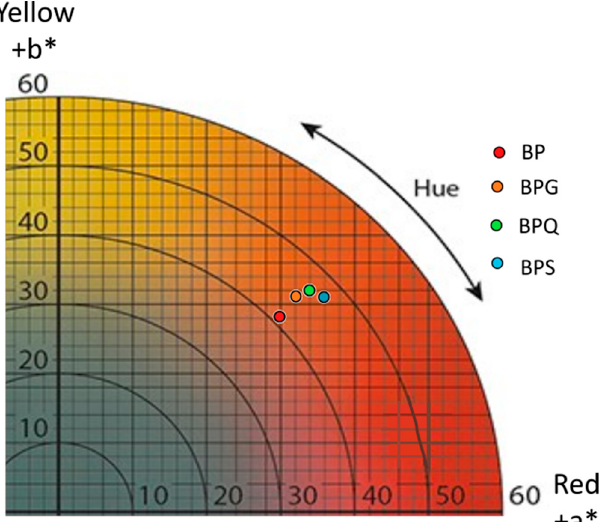
Figure 2. Graphic representing the CIELab coordinated a* (red hue) and b* (yellow hue) of the